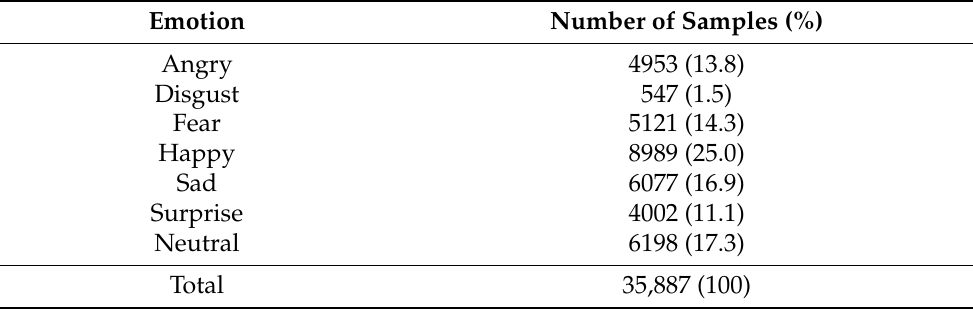
Table 3. The FER2013 number of samples per